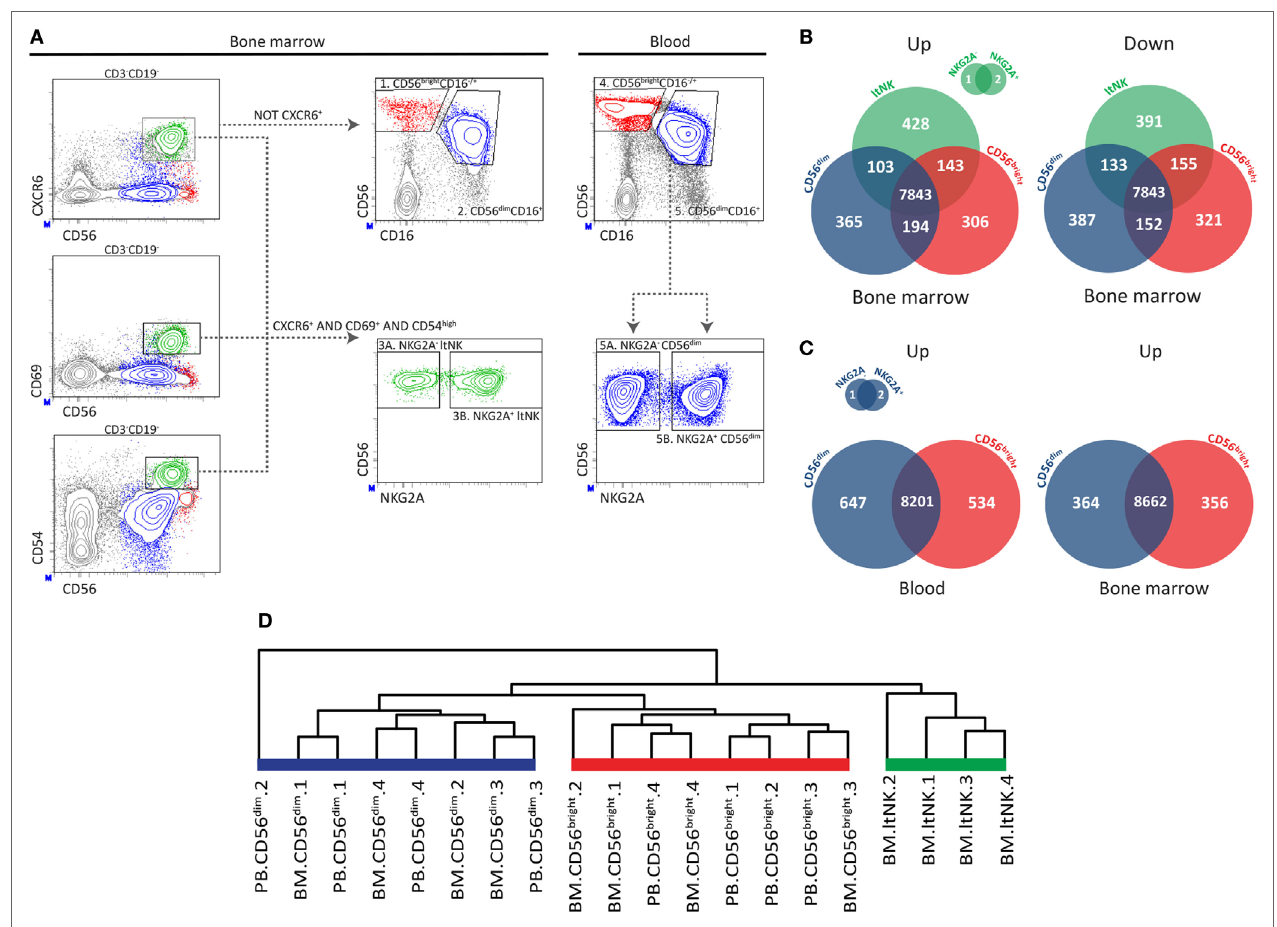
FigUre 1 | RNA sequence analysis confirms distinctiveness of CD56 bright , CD56 dim , and ltNK cells. (a) The applied gating strategy to isolate the different natural killer (NK) cell subsets from bone marrow (BM) and blood is depicted. A representative sample of BM NK cell enriched mononuclear cells is shown. Lymphocytes were gated based on forward and sideward scatter and the doublets were excluded. Residual B and T cells were excluded by selecting CD3 − CD19 − lymphocytes. LtNK cells were defined as CD56 + CXCR6 + CD69 + CD54 + . CD56 + CXCR6 − NK cells were divided into CD56 bright CD16 + / − and CD56 dim CD16 + NK cells. The blood- derived CD56 dim and BM derived ltNK cells were further divided into a NKG2A + and NKG2A − fraction. (B,c) Venn-diagrams illustrating the number of differentially expressed genes (up- and downregulated) between the NK cell subsets in blood and BM. (D) Unsupervised hierarchical clustering of the individual donor samples of BM and blood (PB) derived CD56 bright , CD56 dim , and ltNK cells. The clustering is based on the expression pattern of all the 9,382 genes, which were included in the differential expression